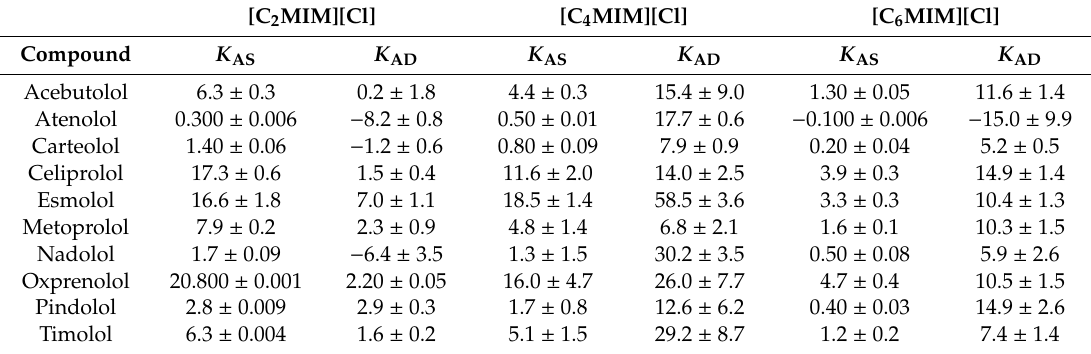
Table 2. Association constants between the solute and stationary phase ( K AS ) and between the solute and additive in the mobile phase ( K AD ) in the presence of chloride ionic liquids (ILs).